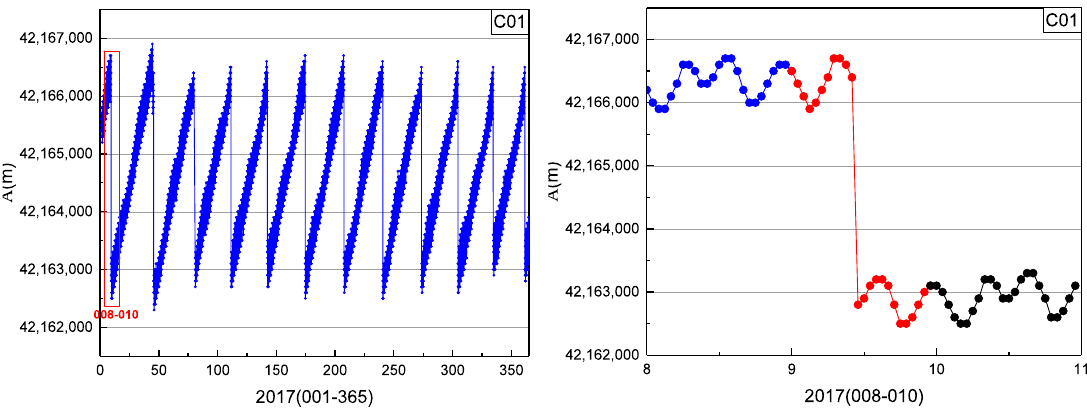
Figure 10. Time series of orbital semimajor axis of C01 in 2017. Graph on the right shows detailed information of the red box (days 008–010) in the plot on the left.